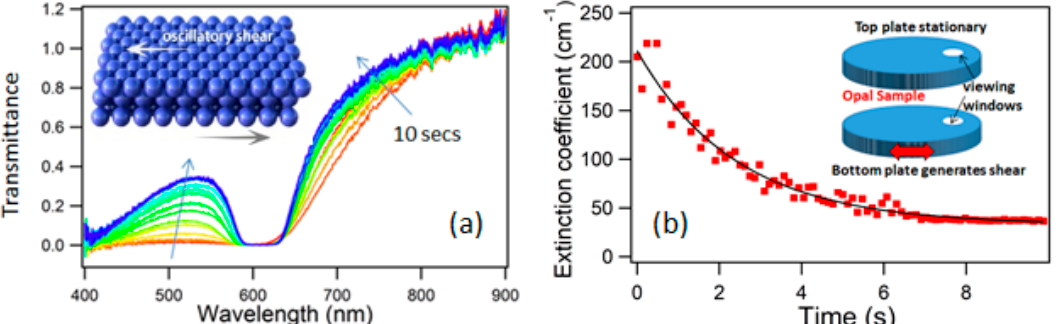
Figure 2. ( a ) Optical spectra taken during the crystallization of an opal sample by means of an oscillatory shear (inset), showing the progress of crystallization over 10 seconds (oscillation frequency of 1 Hz, strain amplitude 200%, shear rate 2 s − 1 ); ( b ) Optical extinction coefficient at λ = 530 nm as a function of shearing time, together with a fit to an offset exponential function, of lifetime τ = 2.4 s. The inset illustrates the experimental geometry used in shear-cell measurements, with the opal sample material introduced to fill the entire space between two plates with optical viewing windows. The parallel plate spacing is 300 μ m, with a total cell volume of ~0.2 μ L. (Adapted from Ref. [44] with permission of American Physical